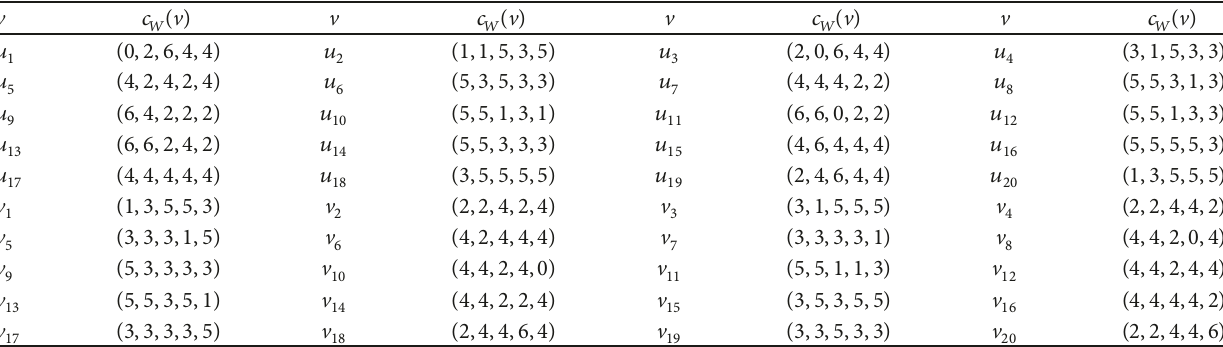
Table 5: The code 𝑐 𝑊 ( V ) of V with respect to 𝑊 = {𝑢 1 , 𝑢 3 , 𝑢 11 , V 8 , V 10 } in 𝑃(20,3)